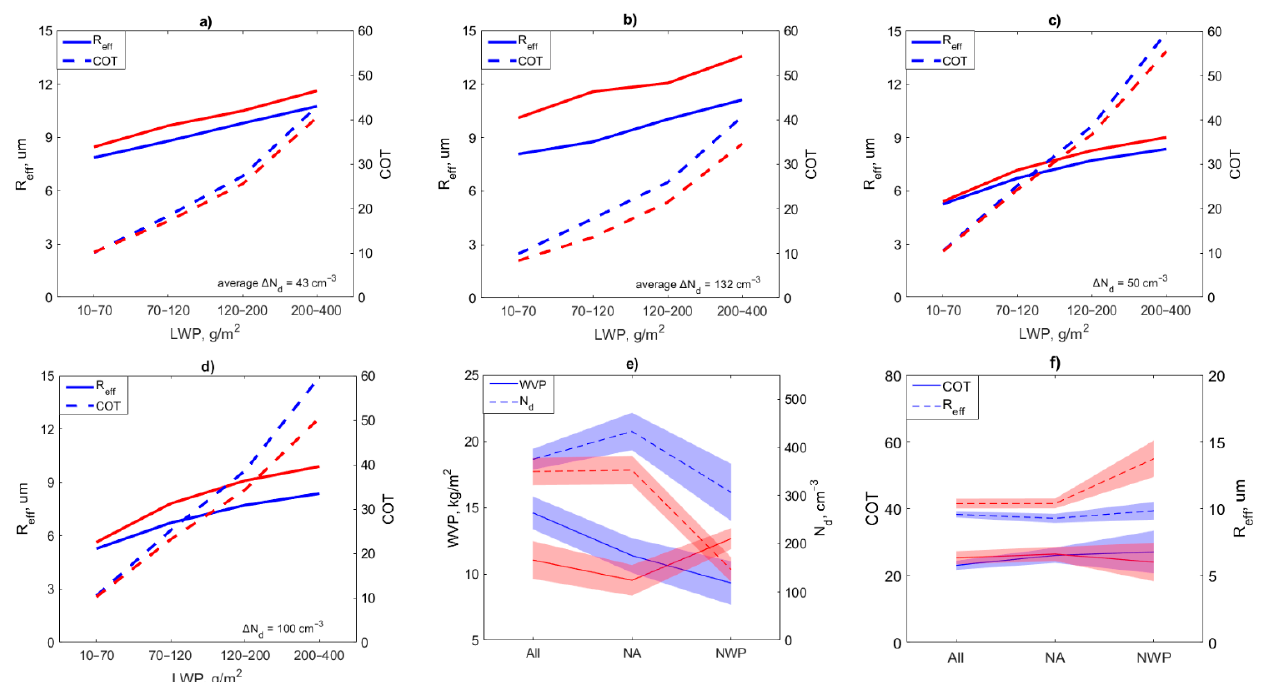
Figure 6. Lockdown 2020 effect on cloud characteristics for different samples: MODIS droplet effective radius and cloud optical thickness for NA ( a ) and NWP ( b ) samples; simulated maximum effective radius in the cloud profile and cloud optical thickness for NA ( c ) and NWP ( d ) samples; reduced samples (coupled MODIS and CERES data) for water vapor path and droplet number concentration ( e ); droplet effective radius and cloud optical thickness ( f ). Data for 2020 are marked by red, for 2018–2019, by blue colors.